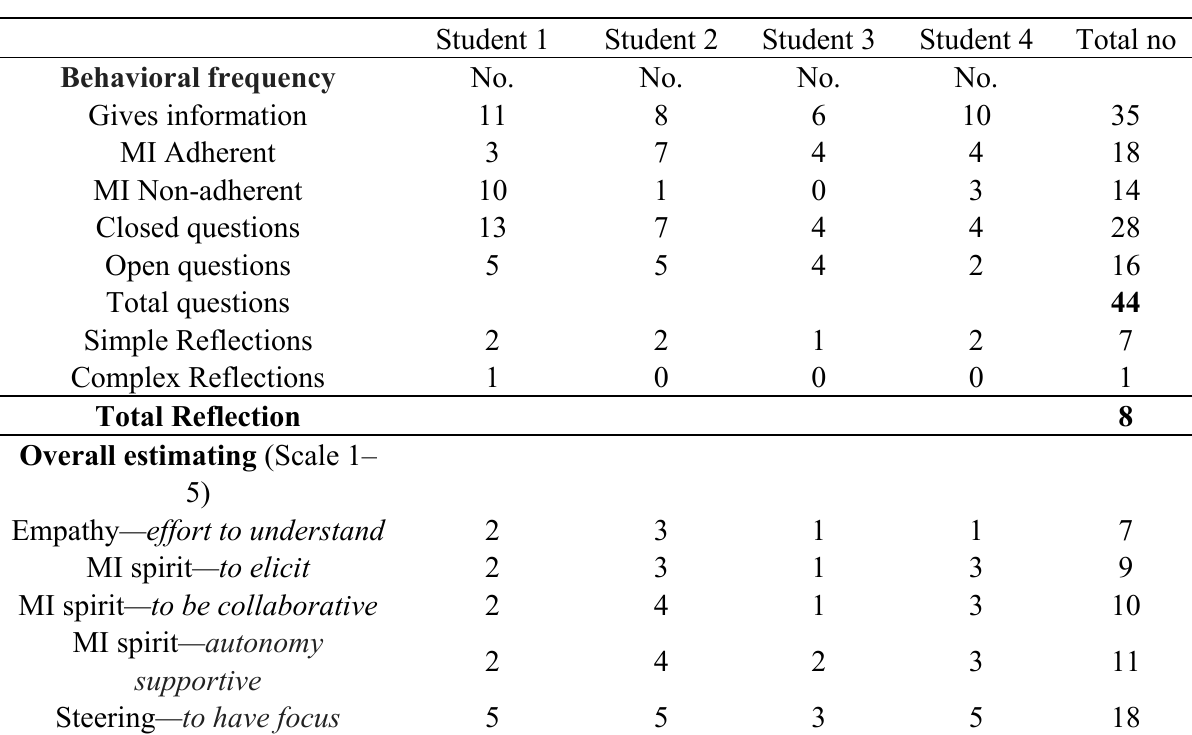
Table 2. Coding of the number of comments from “behavioral frequency” and observations from the “overall estimating” in MI from the students in the control group, according to MITI 3.1.